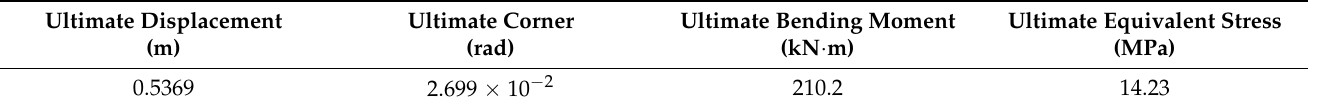
Table 3. Conductor stability parameters under extreme operating conditions.